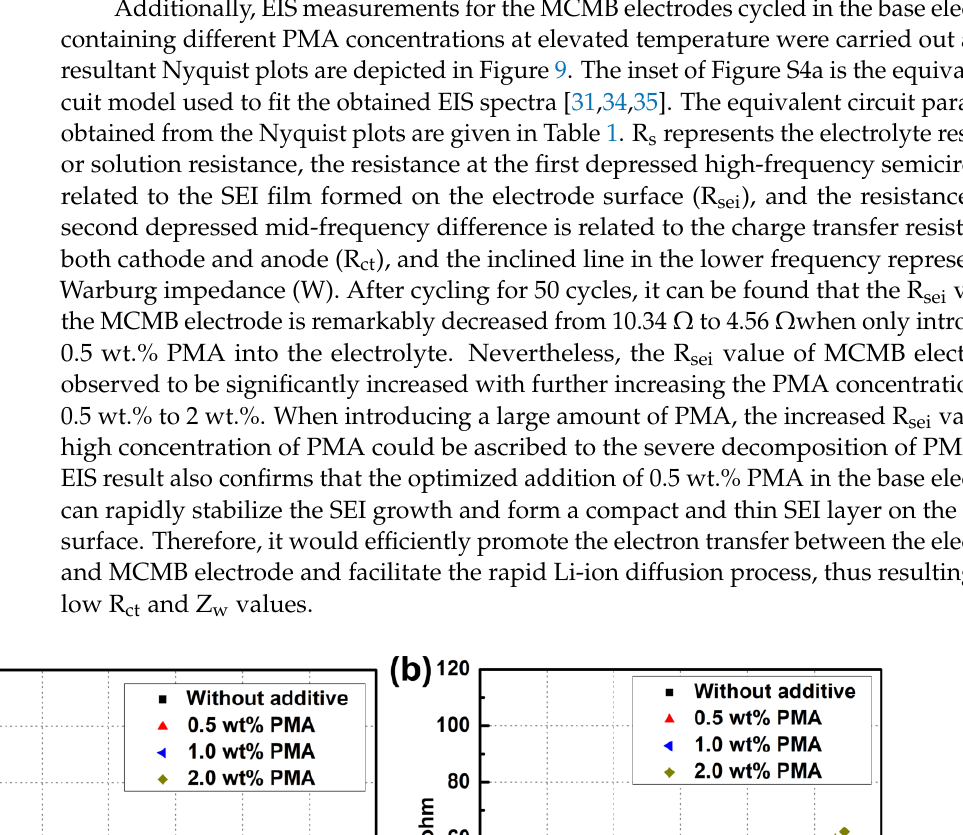
12 of 16 Figure 7. XPS spectra of selected C1s and F1s for MCMB electrodes cycled in the base electrolyte